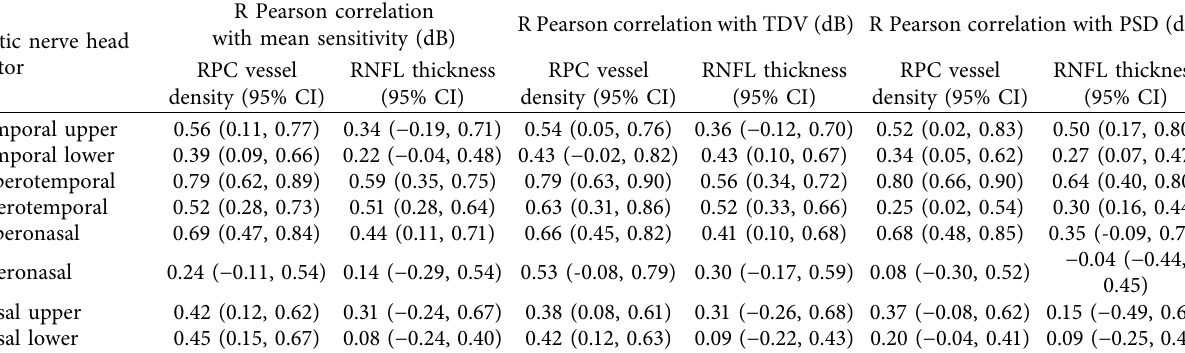
Table 4: Correlations of the RPC vessel density and RNFL thickness with the mean sensitivity, TDV, and PSD in the corresponding optic nerve head sector for glaucoma subjects. R Pearson correlation with TDV (dB) R Pearson correlation with PSD (dB)